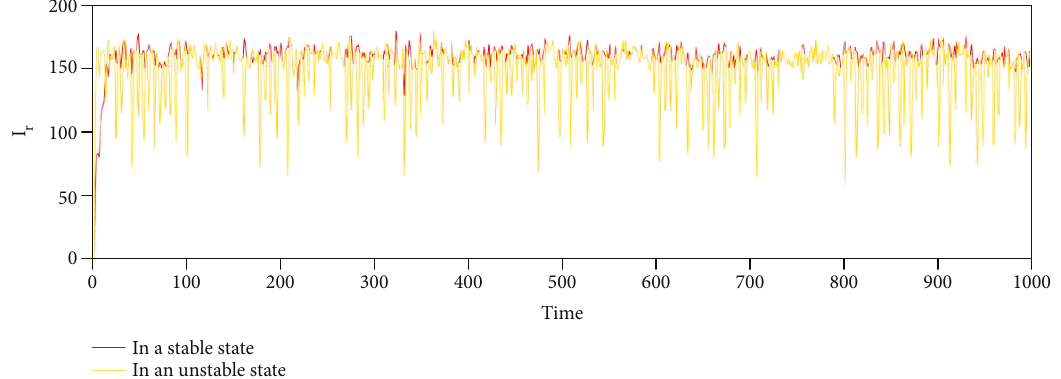
Figure 19: Comparison of retailers ’ initial stock changes in a stable state and unstable state under the scenario of random demand obeying normal distribution.